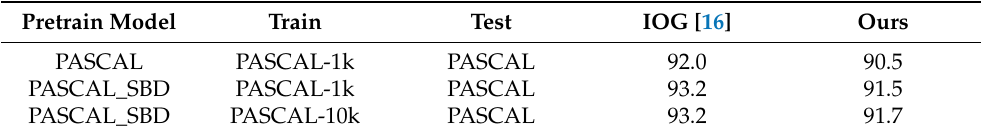
Table 4. Ablation experiments. Justification of the pretrained model and the number of training images on the PASCAL VOC 2012 val